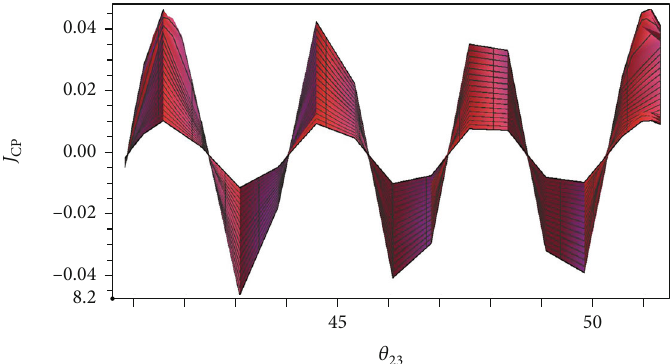
∈ ½ 40 : 8,51 : 3 (cid:2) , for as a function of θ , θ CP 23 23